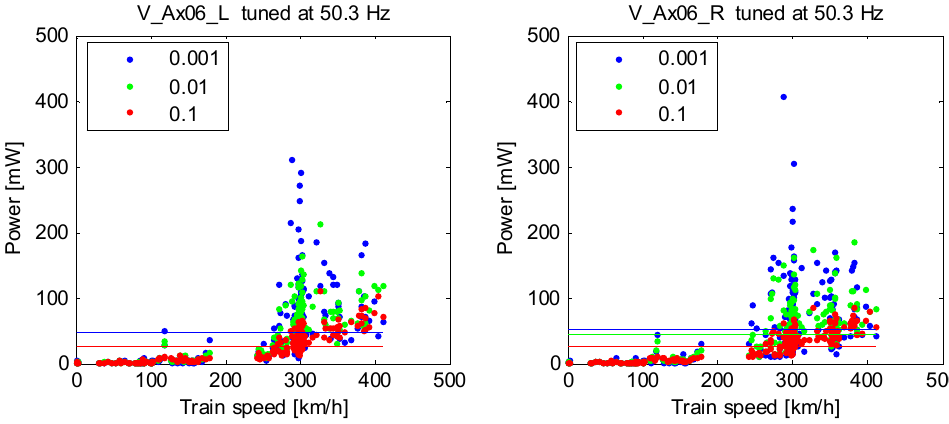
Figure 11. The estimated power generation from the vertical vibration of the axles when the total damping ratio ξ T is 0.001, 0.01 or 0.1; the mass is 0.1 kg; and the natural frequency is 50.3 Hz (at the vertical direction of each left and right side of the number 6 axle: V_Ax06_L and V_Ax06_R).